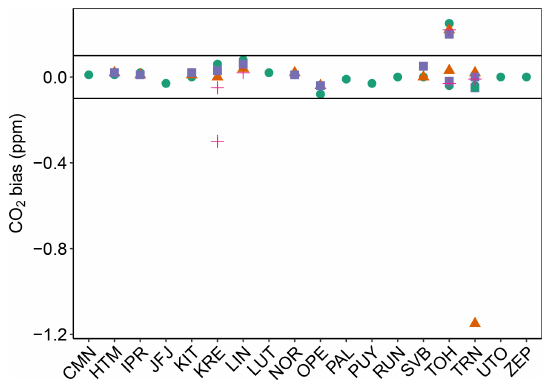
Figure 19. CO 2 difference between the reference injection and the injection before the shelter’s first element. The different colors and shapes show the difference at each sampling levels (green dot: lower level; orange triangle: second level; purple square: third level; pink cross: fourth level). The same color and shape at one given site indi- cate that several tests have been performed (e.g., TOH). The black lines show the WMO compatibility goals.